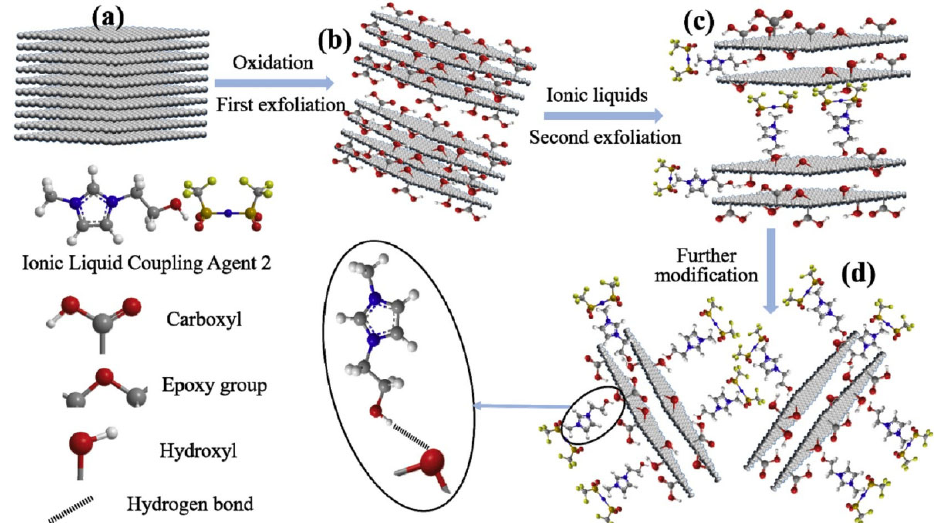
Fig. 3 Schematic about the preparation and modification mechanisms of ILCAs-GO. (a) Natural flake graphite, (b) MGO sheets, (c) ILCAs-GO sheets, (d) partial enlargement image of junction at ILCAs and oxygen-containing group of GO (take the case of epoxy group) [20]. Reproduced with permission from Ref. [20], © Elsevier Ltd.,